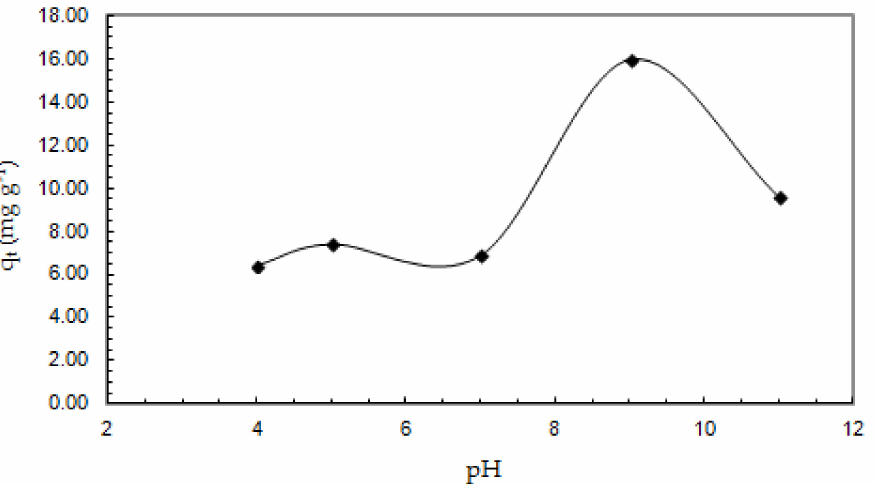
Figure 5. The effect of solution pH on the adsorption capacity of Sb (III) onto ox-xGnP (0.7 mg L − 1